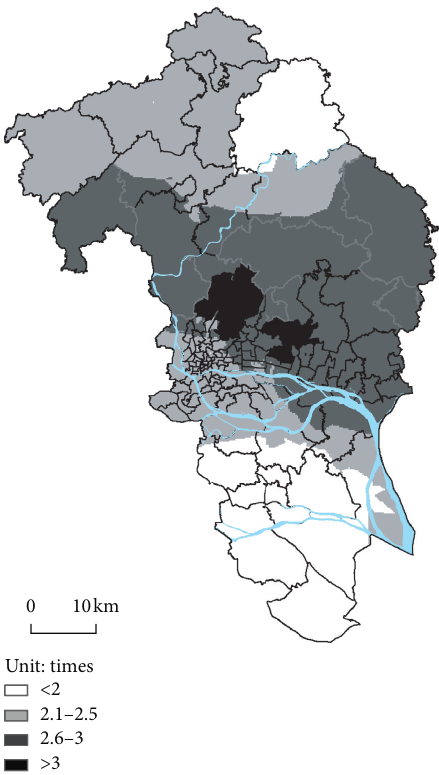
Figure 4: Spatial differences in housing prices in Guangzhou